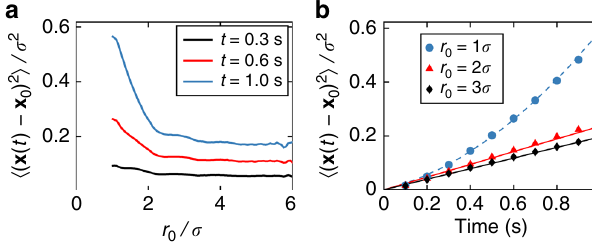
Fig. 4 Mean squared displacement (MSD) near the interface between domains of opposite rotors. a MSD after 0.3 s, 0.6 s, and 1.0 s in dependence on the distance to the closest opposite rotor r 0 (i.e., the interface) at time t = 0 in units of particle diameter σ . b Time dependence of the MSD for particles at distances 1 σ , 2 σ and 3 σ from the interface. MSD of particles in direct contact with the interface increases quadratically (dashed line). Particles further away from the interface show a linear MSD (solid